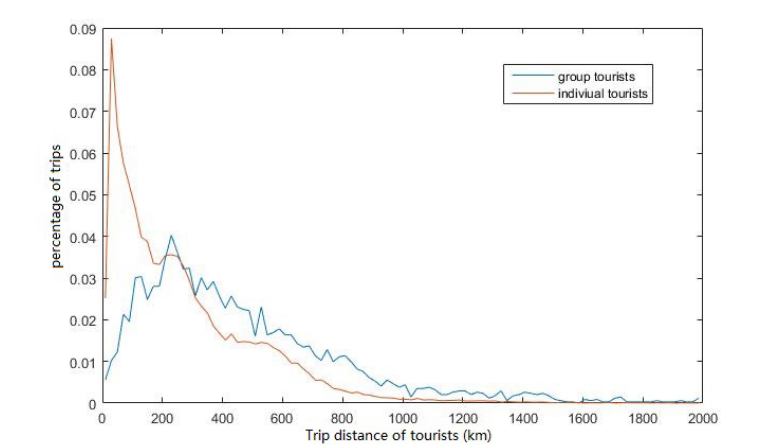
Figure 7. Trip distance of tourists for group and individual tourists.